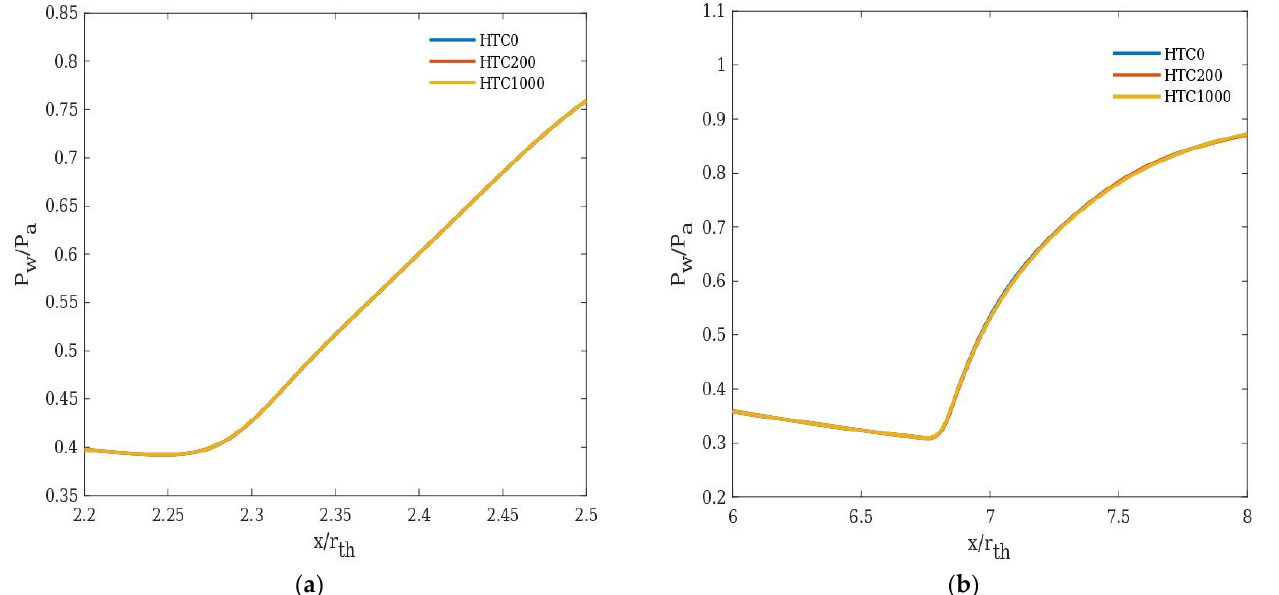
Figure 14. Wall pressure distribution at an inlet temperature of 1500 K for different heat transfer coefficients: ( a ) NPR 14 and ( b ) NPR 40.